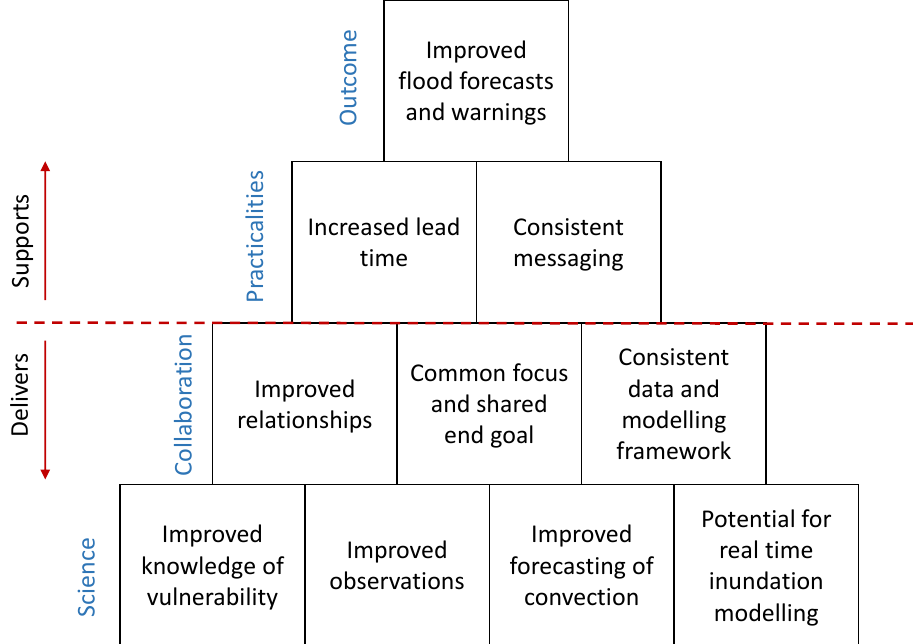
Figure 5. The achievements from the FFIR programme and how they impact the end users and the end-to-end forecasting chain. Whilst data assimilation has not been explicitly shown in this schematic it is treated within the improved forecasts